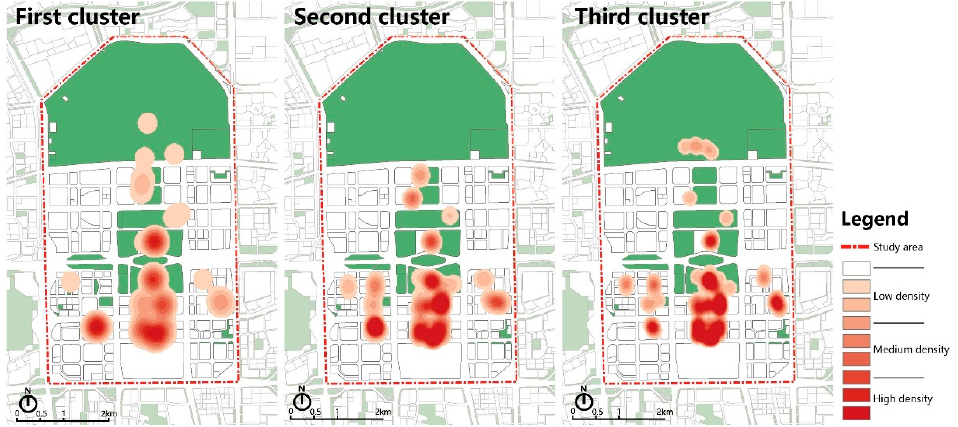
Figure 9. Track point kernel density analysis of green land use clusters.